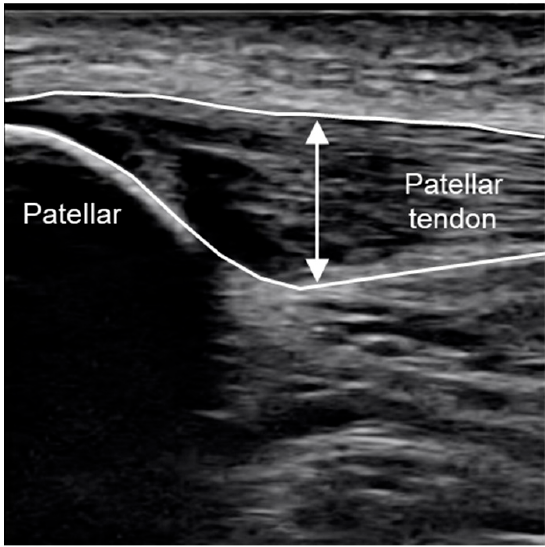
Figure 1. Measurement for Patellar tendon thickness.